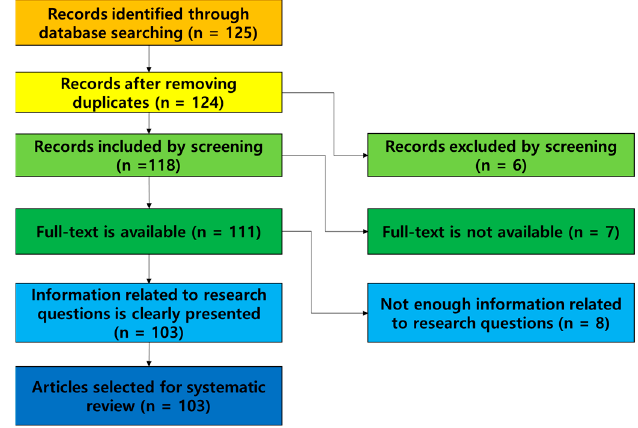
Figure 1. Flow chart of selection criteria.